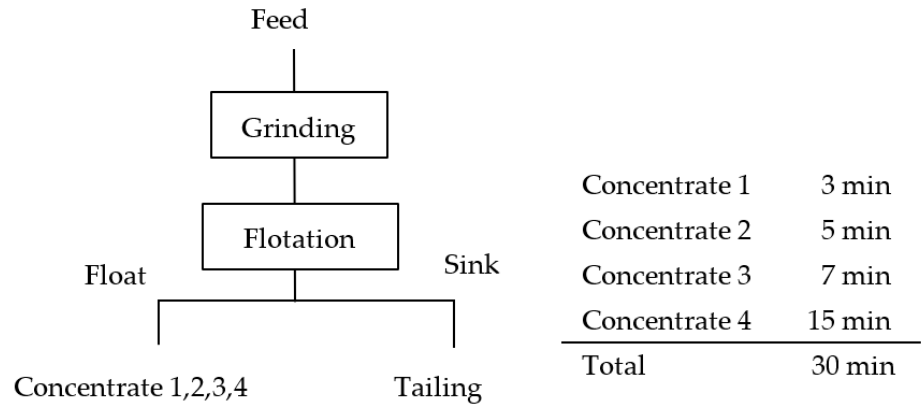
Figure 1. Flowsheet of flotation experiment procedure.